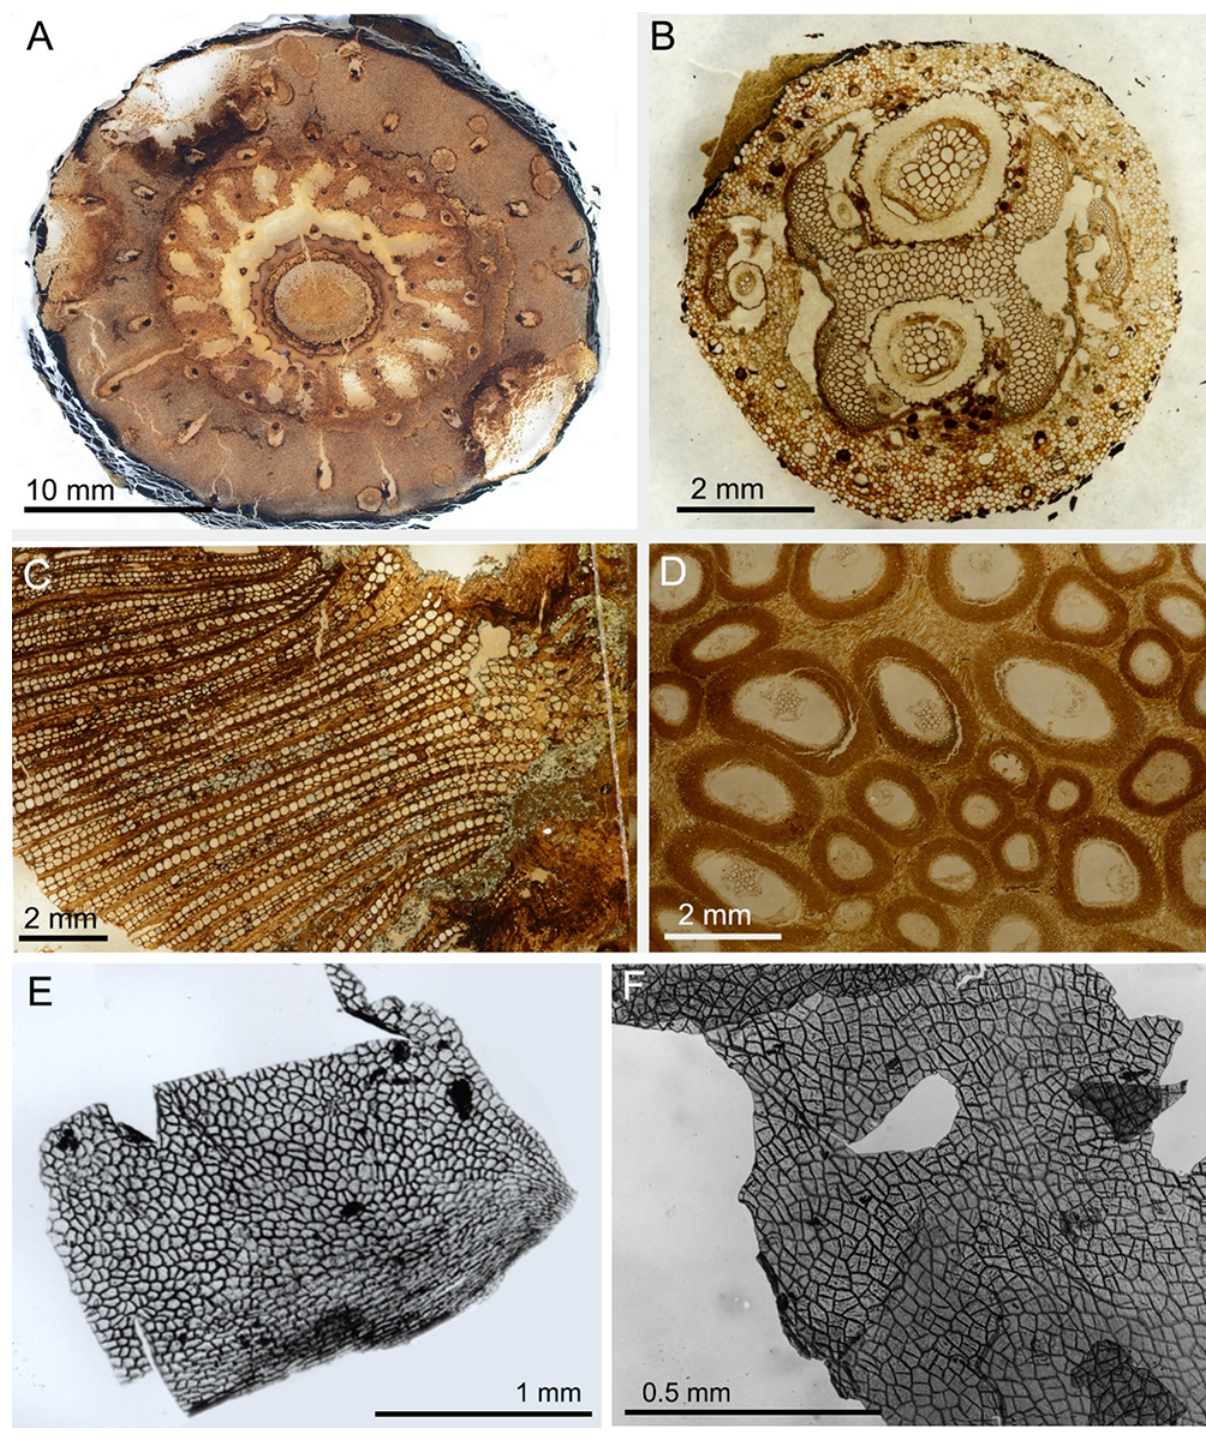
Figure 5 Carboniferous plants from the Upper Silesian Coal Basin. Petrified remains ( A–D ) and dispersed cuticles ( E,F ). Transverse sections through petrified remains from the Upper Carboniferous (Namurian A): ( A ) Lepidophloios cf. wünschianus Carruthers – transverse section of young stem, specimen II-B, Jankowice coal mine; ( B ) Etapteris cf. diupsylon Williamson – transverse section of leaf axis (phyllophore), H-shaped xylem stele visible, specimen XII-A, Marcel coal mine near Rybnik; ( C ) Medullosa sp. – transverse section of stem fragment with secondary xylem visible, specimen unnumbered, Chwałowice coal mine near Rybnik; ( D ) Psaronius sp. – transverse section of fragment of inner layer of adventitious roots mantle, specimen XIII-A, Radzionków coal mine. Cuticle dispersae from Upper Carboniferous coals of the Upper Silesian Coal Basin: ( E ) Small leaf fragment, Jaworzno coal mine, seam 302; ( F ) indetermined cuticle, Ziemowit coal mine, seam 308. Specimens from ( A–D ) stored in PC IB UJ; specimens from ( E,F ) from the S. Florjan collection, stored in Nature Education Centre, Jagiellonian University (all photos by S.